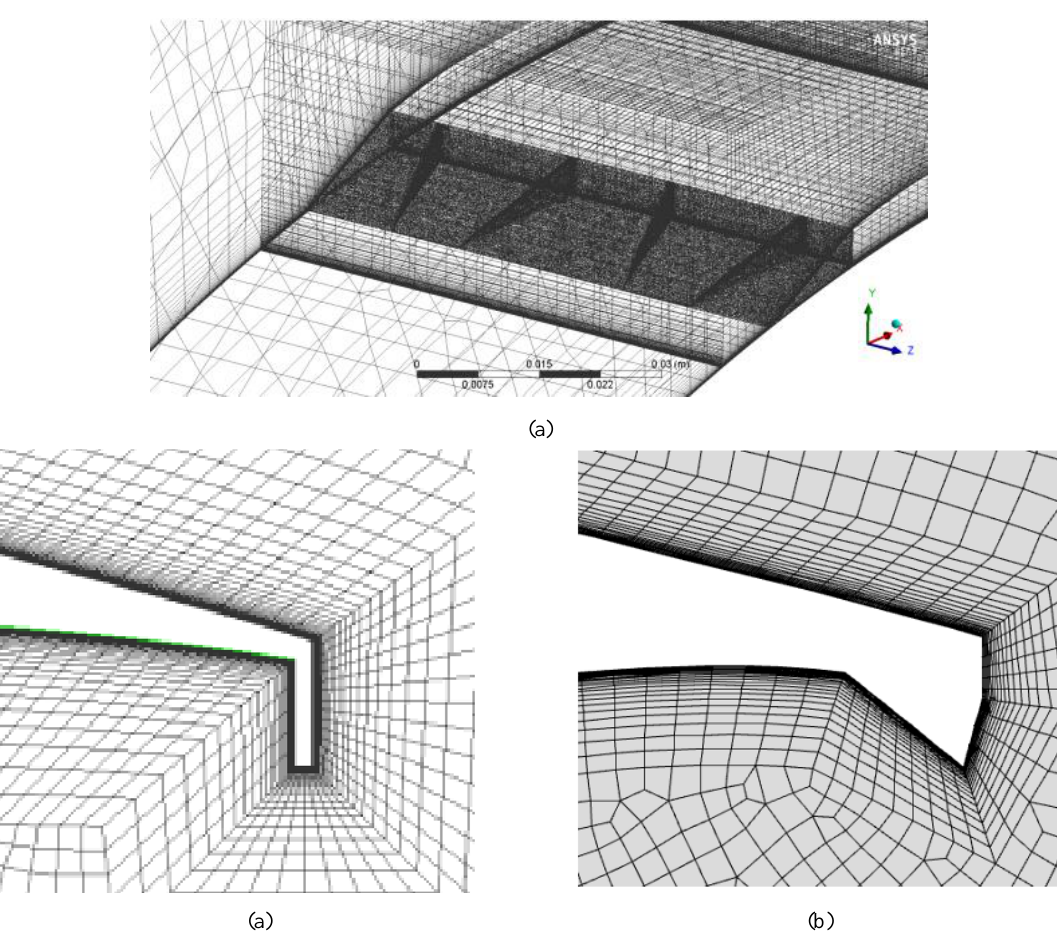
Figure 6. Nearfield pictures of grid in the regions of (a) vortex generators, (b) Gurney flap and (c) trailing-edge wedge To perform grid independent study, lift and drag coefficients of the airfoil equipped with VGs for three grid levels are obtained and compared. The first grid level has around 910,000 computational cells. The second and third grid levels are obtained by 30% increase in the computational cells relative to the prior grid level. So, the second and third grid levels have around 1,180,000 and 1,530,000 computational cells, respectively. Exploring the generated grids shows that for the three grid levels, maximum value of y + (= 𝑦√𝜏/𝜌/𝜈 , where 𝜏 stands for wall shear stress and 𝜈 is fluid kinematic viscosity) is around y + ≈ 1. Figure 7 presents the obtained lift and drag coefficients of the airfoil for the three grid levels. Figures 8 and 9 also present the lift and drag coefficients of the airfoil equipped with VGs in the presence of Gurney flap and trailing-edge wedge with H / c =2% for the considered grid levels. These figures confirm that the second grid level has enough accuracy for numerical